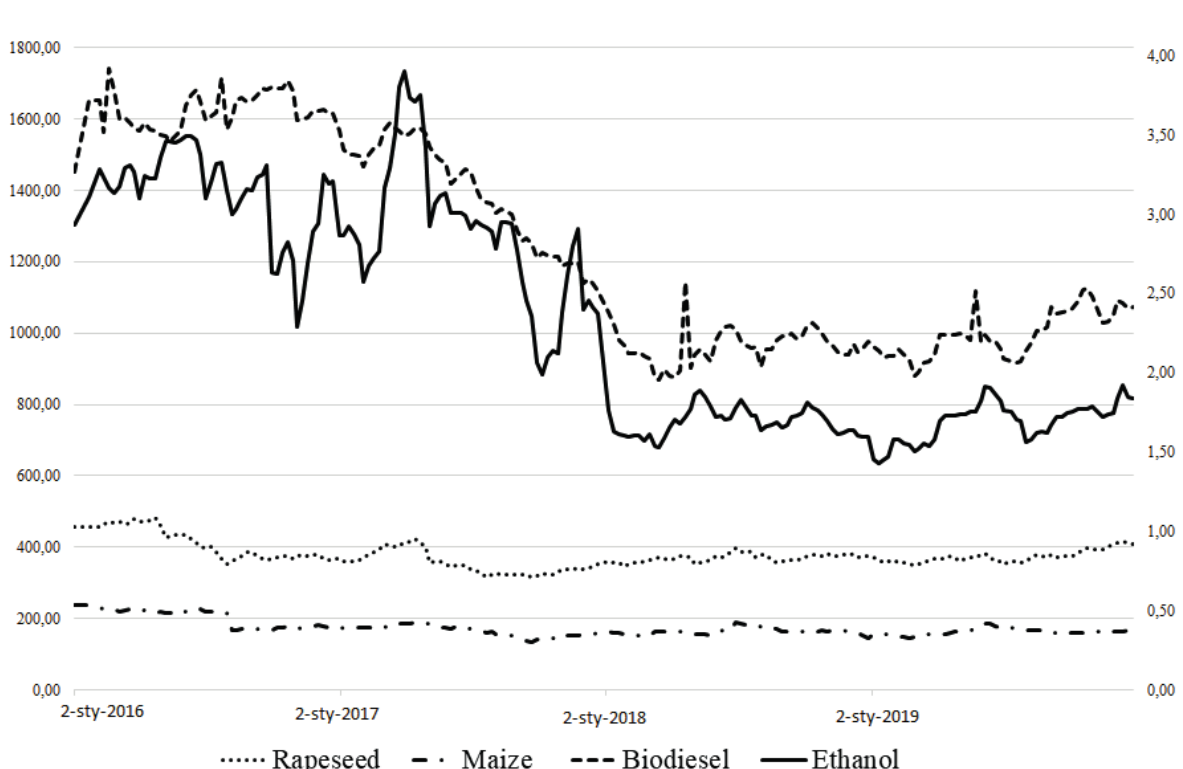
Figure 2. Price level of rapeseed, maize, biodiesel and ethanol prices in the analyzed period in nominal terms (in EUR). Source: Own calcu- lations and analysis with the use of EViews software.